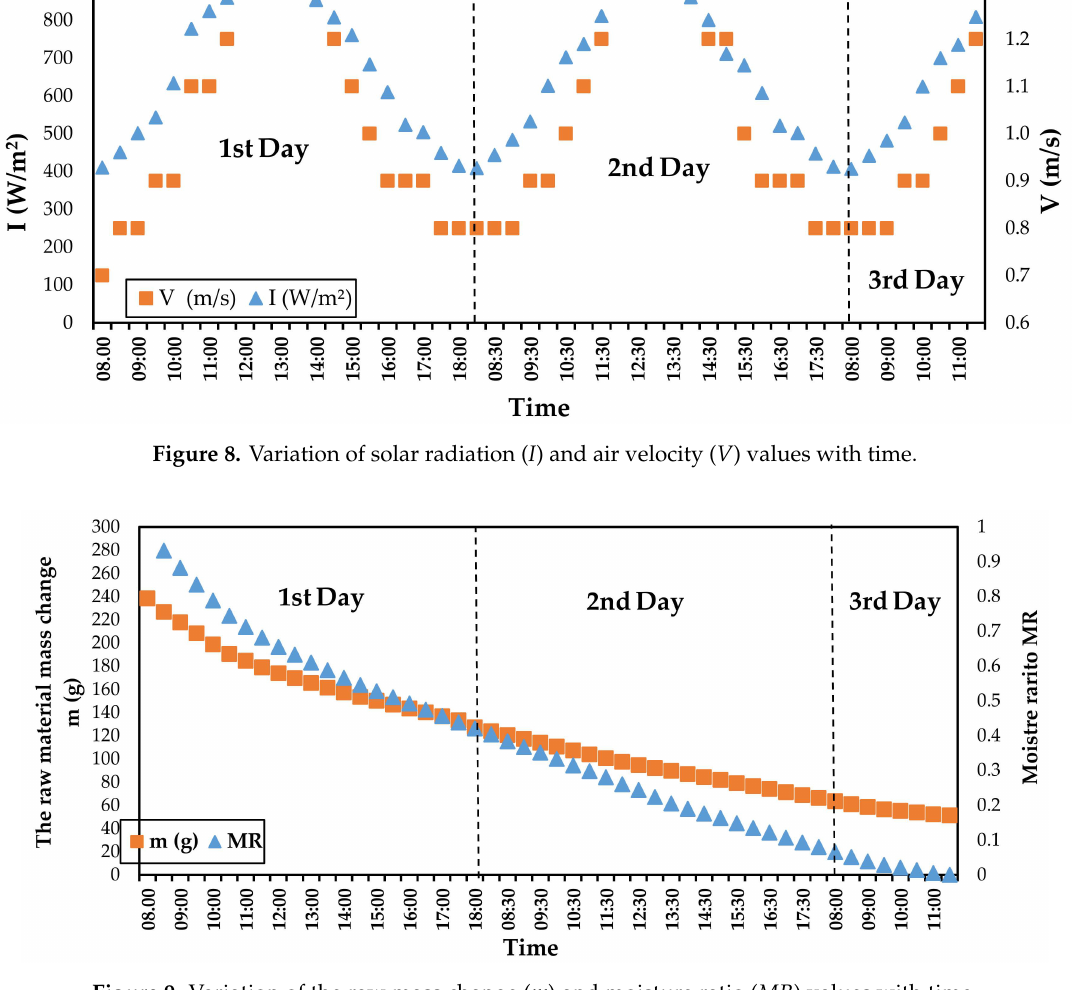
Figure 9. Variation of the raw mass change ( m ) and moisture ratio ( MR ) values with time.